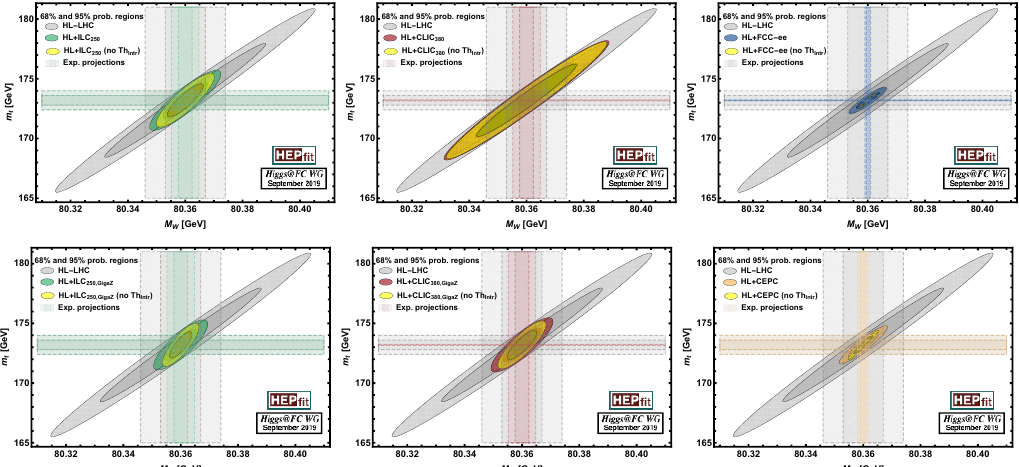
Figure 18 . Constraints on m W and m top from direct measurements (horizontal and vertical lines) and indirect constraints (ellipses). In all cases the constraints from current data plus HL-LHC are compared to the ones expected for the e + e (cid:0) collider. For ILC and CLIC the result is shown without (top row) and with a Giga-Z (bottom row) run.